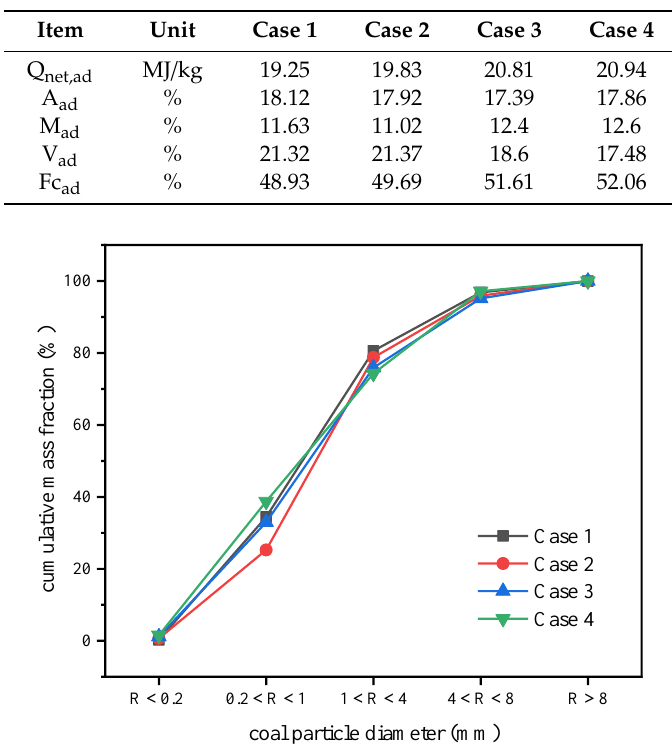
Figure 3. Particle size distributions of the feeding coal under various working conditions.